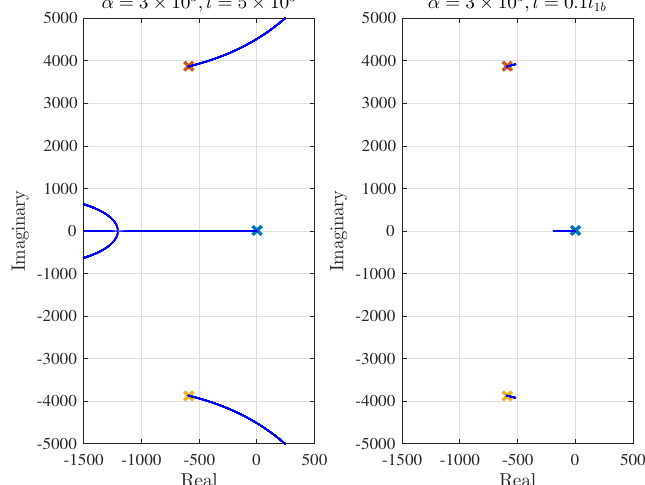
Figure 6. Root trajectories of ROPIO compensated ROMBC when α = 3000 for l = 5000 ( left ) and l = 0.1 l 1 b = 189.43 ( right ).